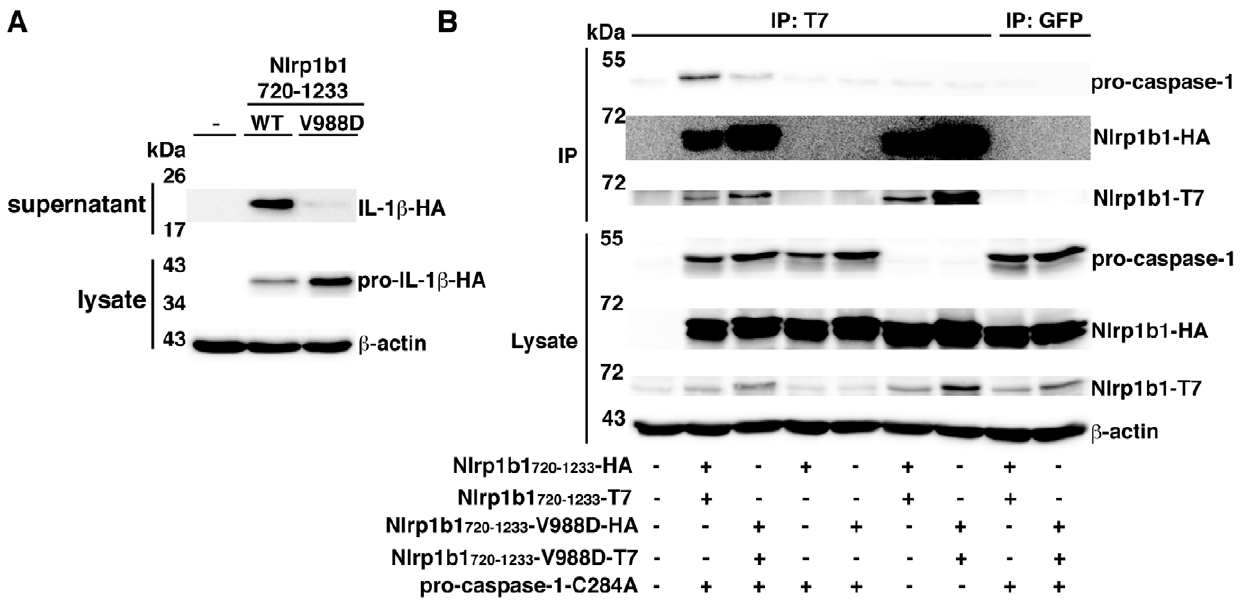
Figure 8. The V988D mutation in Nlrp1b1 720–1233 reduces its ability to associate with pro-caspase-1. (A) HT1080 cells were transfected with pcDNA3-pro-caspase-1-T7 and pcDNA3-pro-IL-1 b -HA and co-transfected as indicated with pNTAP-Nlrp1b1 720–1233 -HA, pNTAP-Nlrp1b1 720–1233 - T7, pNTAP-Nlrp1b1 720–1233 -V988D-HA, and pNTAP-Nlrp1b1 720–1233 -V988D. Approximately 24 h after transfection, cell lysates were collected and probed for HA-tagged pro-IL-1 b and b -actin; cell supernatants were collected and immunoprecipitated with anti-HA antibodies and probed for HA- tagged IL-1 b by immunoblotting. (B) Cells were transfected with indicated combinations of pNTAP-Nlrp1b1 720–1233 -HA and pNTAP-Nlrp1b1 720–1233 -T7 WT or V988D as well as with pcDNA3-pro-caspase-1-C284A-FLAG and pcDNA3-pro-IL-1 b -HA. Approximately 24 h following transfection, cells were lysed and immunoprecipitated using an anti-T7 antibody. Proteins were immunoblotted with antibodies against HA, caspase-1, T7 and b -actin. Blots are representative of three independent experiments.